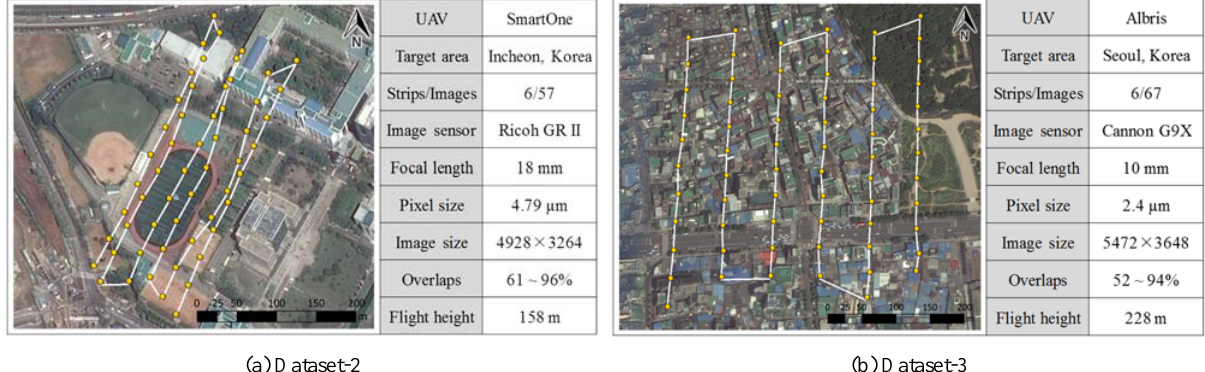
Figure 4. Image datasets produced for evaluation of the proposed